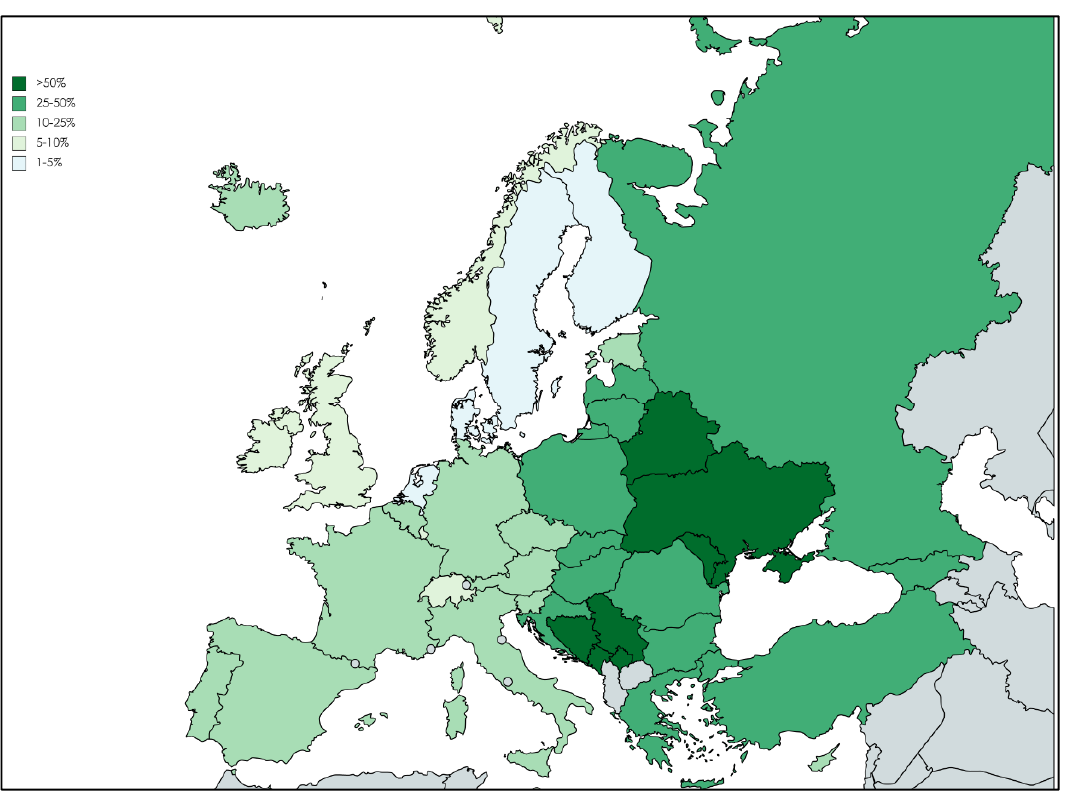
Figure 1. Percentage of invasive P. aeruginosa isolates with resistance to carbapenems, 2020. Map was created through the online tool Mapchart.net (https://mapchart.net/world.html, accessed on 20 April 2022).